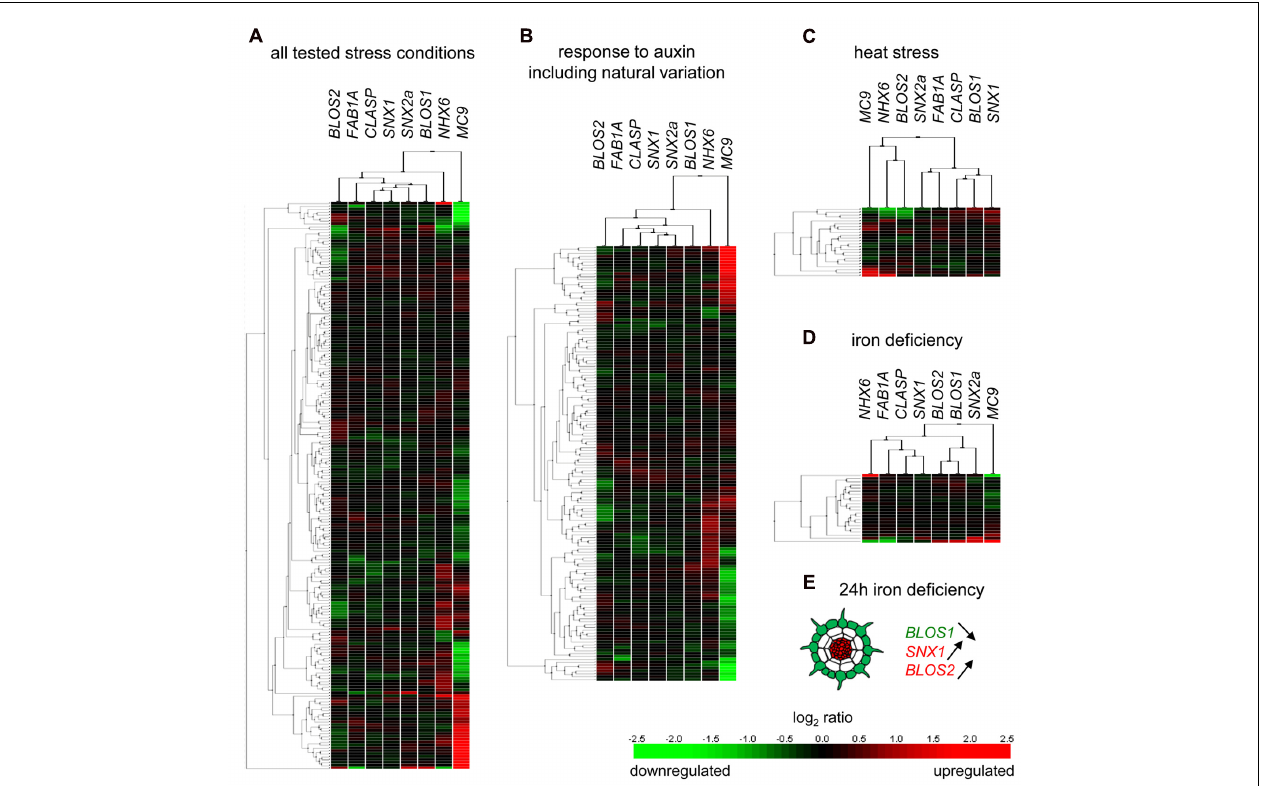
FIGURE 4 | Hierarchical clustering of SNX1-interactor gene expression in response to environmental inputs. External inputs were chosen where plant responses require the function of SNX1. These include: (A) a combination of all stresses, (B) auxin application, including the responses of different Arabidopsis accessions, (C) heat stress, and (D) iron deficiency. (E) Radial-zone gene expression changes after 24 h of iron deficiency. Green color indicates downregulation in the performed comparisons, red color indicates upregulation. Panels (A–D) were generated using the Genevestigator